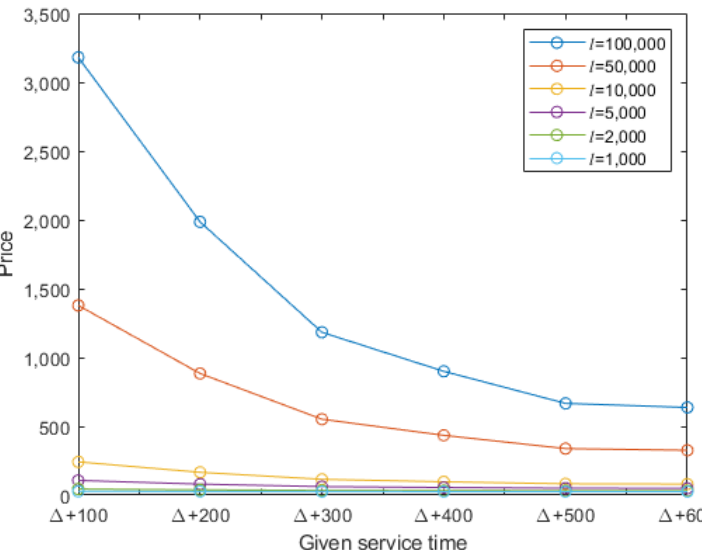
Figure 8. Service price based on different values of l and time limitations: (cid:52) + 100 s, (cid:52) + 200 s, (cid:52) + 300 s, (cid:52) + 400 s, (cid:52) + 500 s, (cid:52) + 600 s, and (cid:52) + 100 s, where (cid:52) denotes the minimum service time.